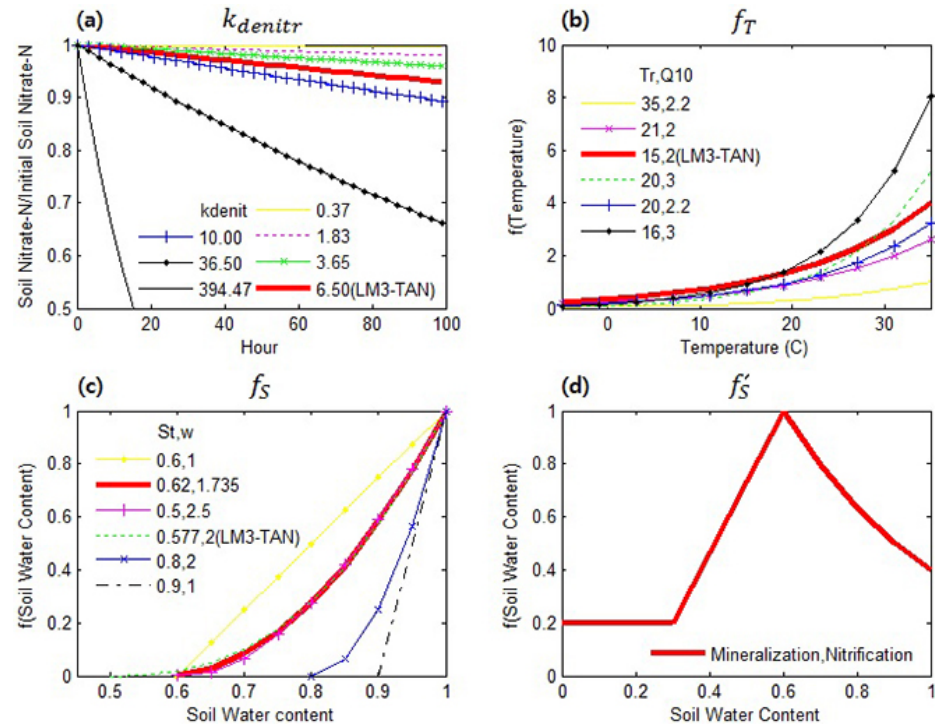
Figure 2. Overview of the denitrification module. Effects of first-order denitrification coefficient (a) , soil temperature reduction function (b) , soil water content reduction function (c) on soil denitrification rate, and soil water content reduction function for mineralization and nitrification (d) . The curves were produced using Tables 3, 6, and 7 in Heinen